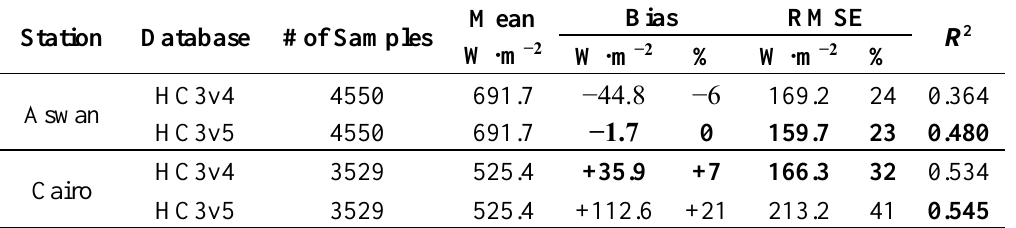
Table 8. Validation of the DNI under all-sky conditions, the best values for each station are in bold.